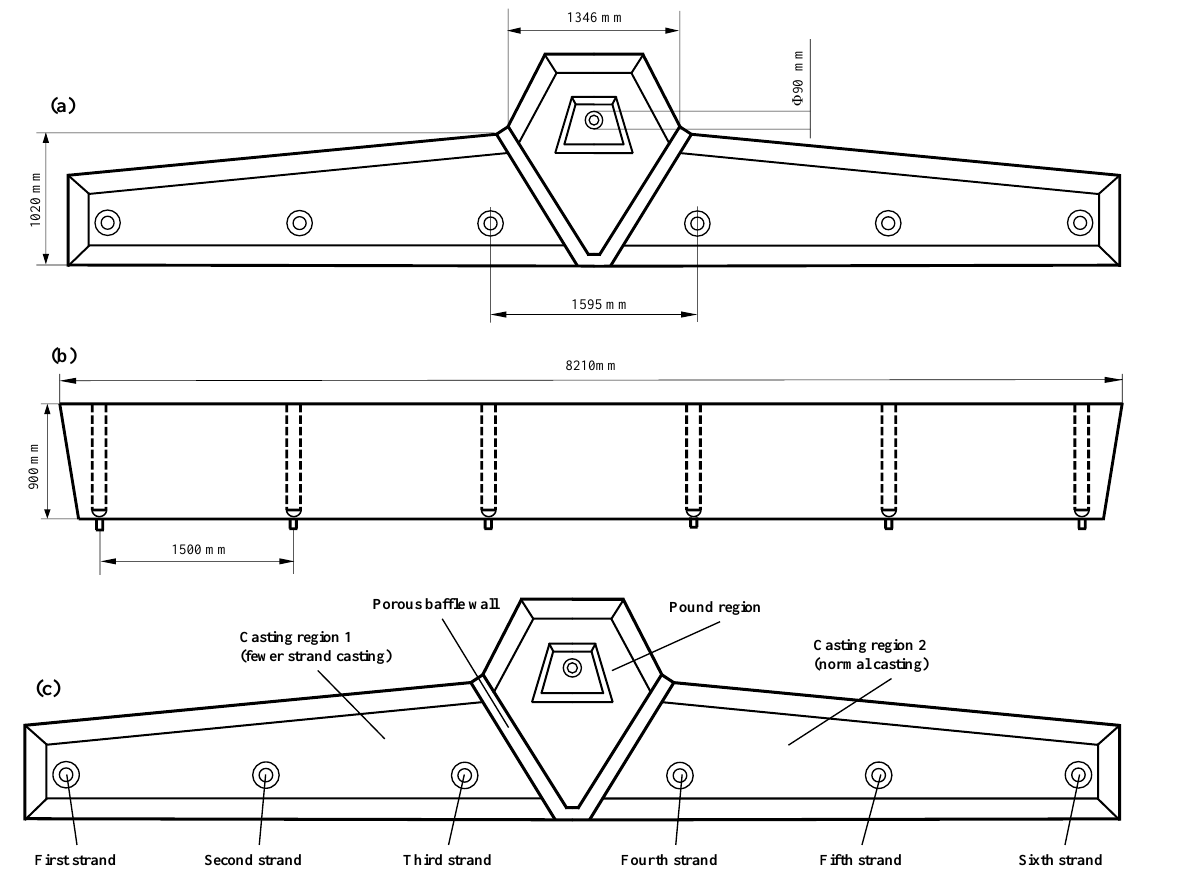
Figure 1. Diagram of tundish structure: vertical view ( a ); front view ( b ); schematic diagram of fewer strands casting ( c ).